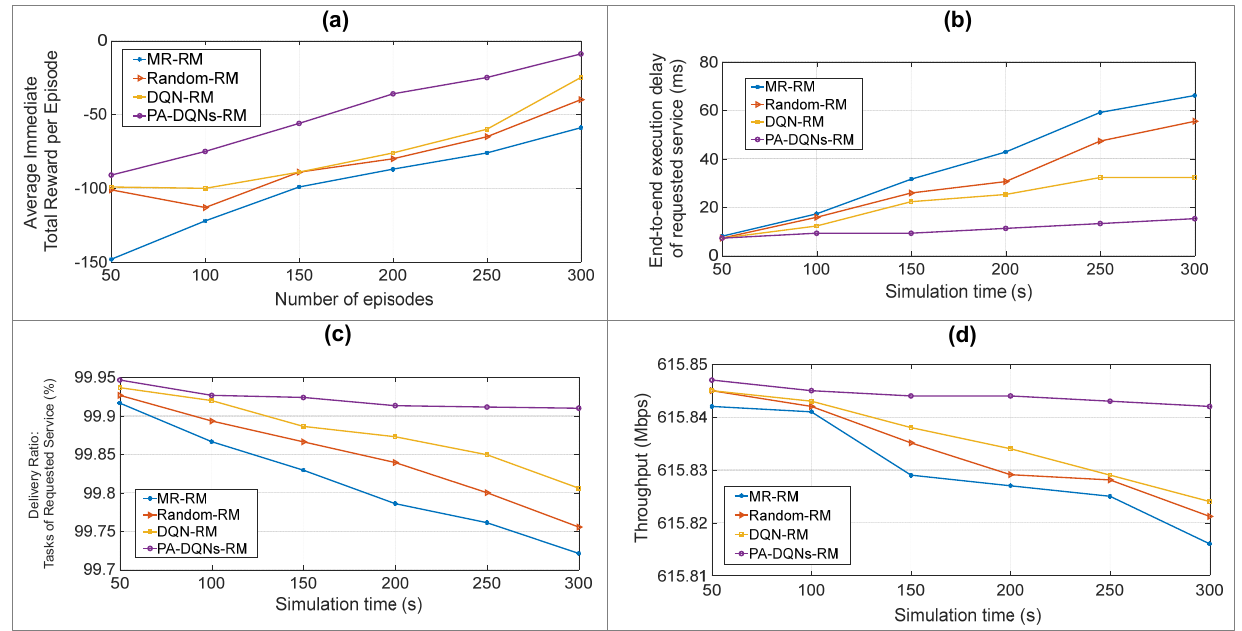
Figure 5. Performance metrics for proposed and reference schemes, including ( a ) the average immediate total reward per 50 episodes, ( b ) end-to-end execution delay of requested services, ( c ) delivery ratio, and ( d ) throughput.